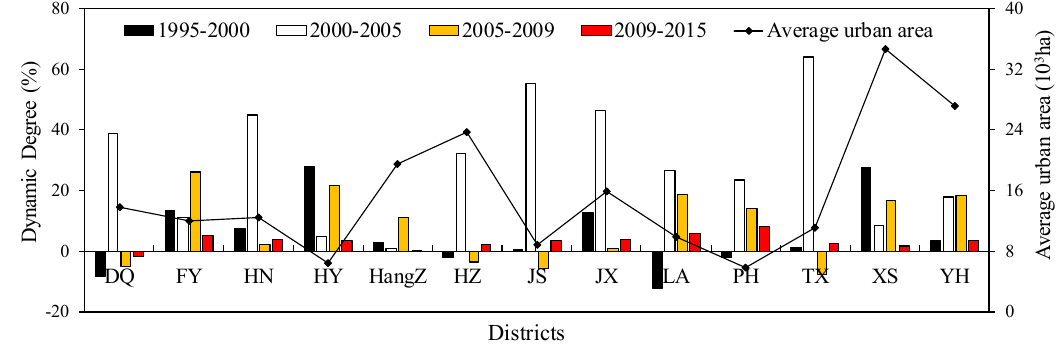
Figure 4. Dynamic degree and average area of urban in 13 districts from 1995 to 2015.